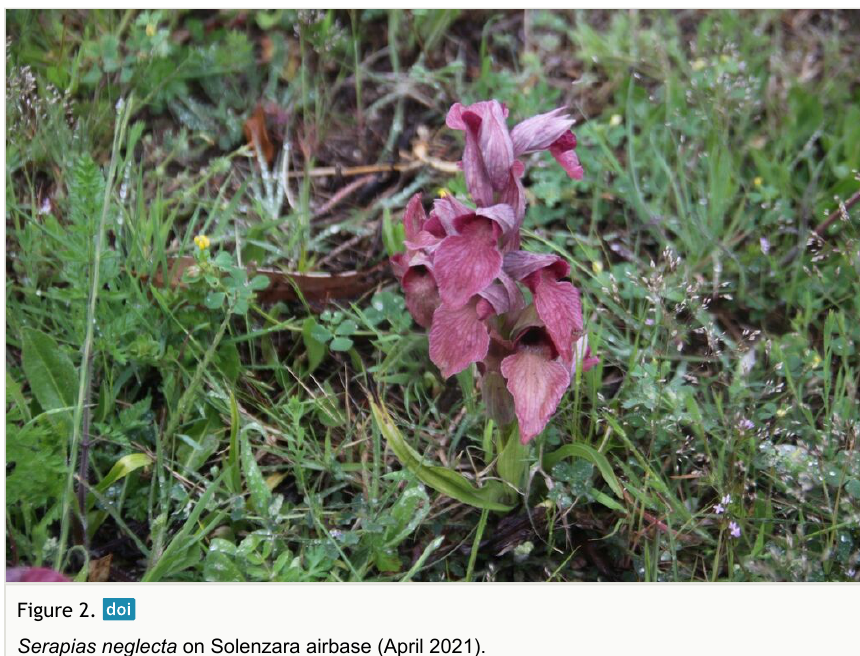
Figure 2. Serapias neglecta on Solenzara airbase (April